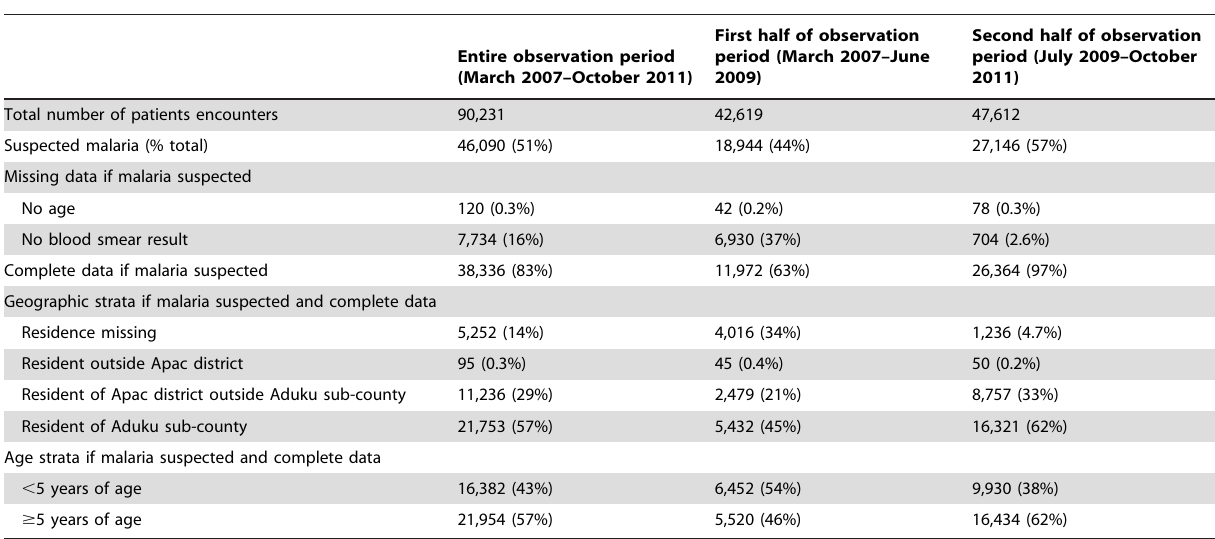
Table 2. Characteristics of the study